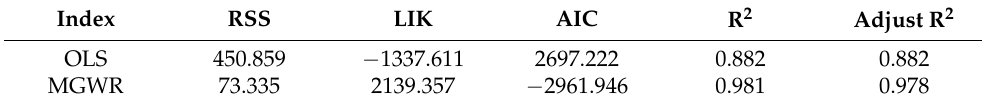
Table 6. Model regression results for summer 2020.